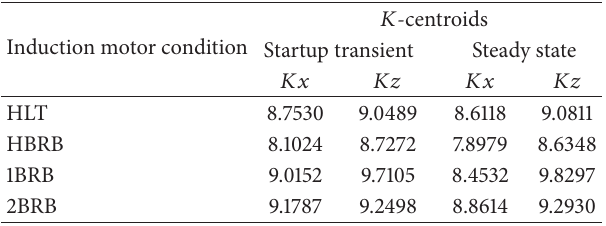
Table 2: Values of the 𝐾